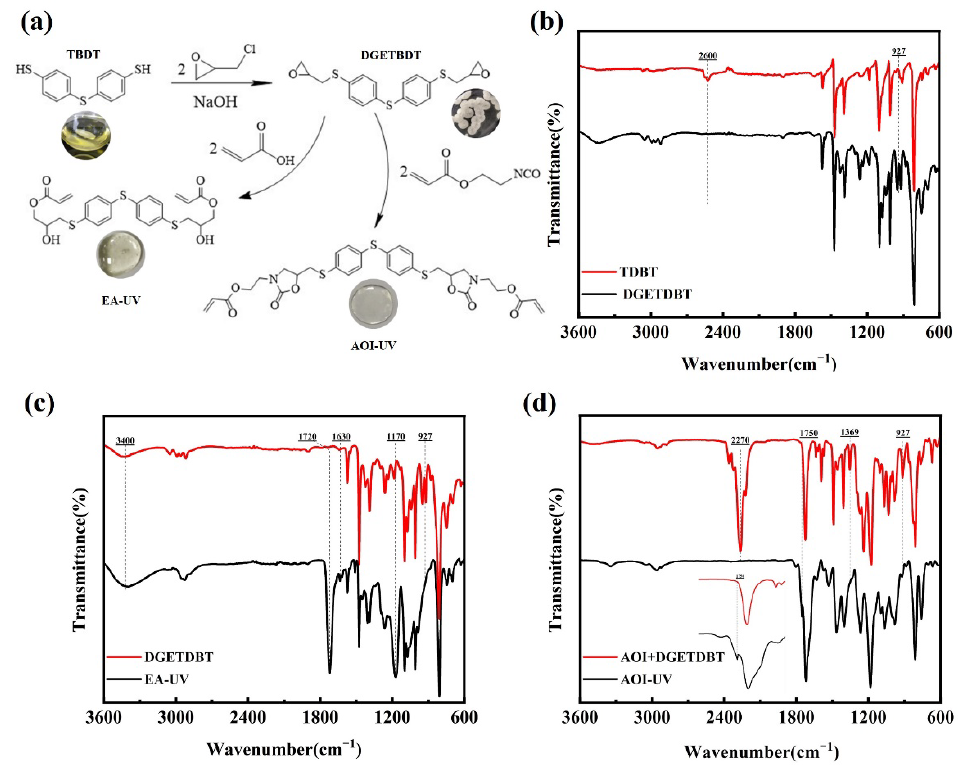
Figure 6. Synthesis and characterization of photopolymers. ( a ) Synthesis of photopolymers. ( b ) FTIR spectra of DGETDBT. ( c ) FTIR spectra of EA-UV. ( d ) FTIR spectra of AOI-UV.